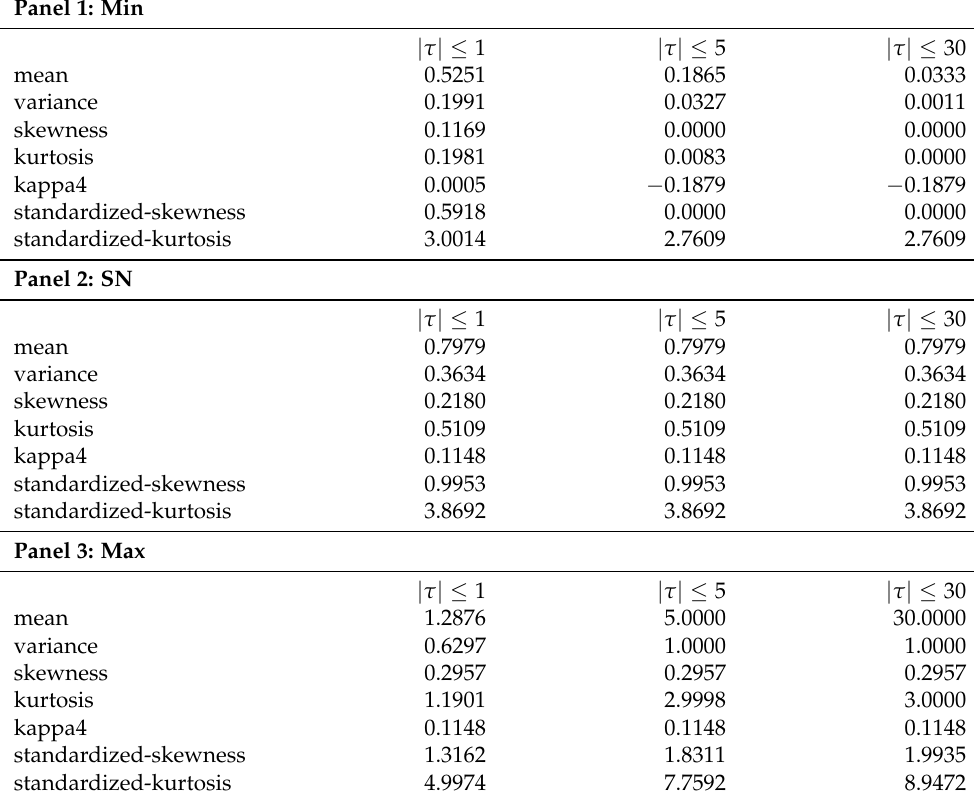
Table 1. Moments of the truncated normal